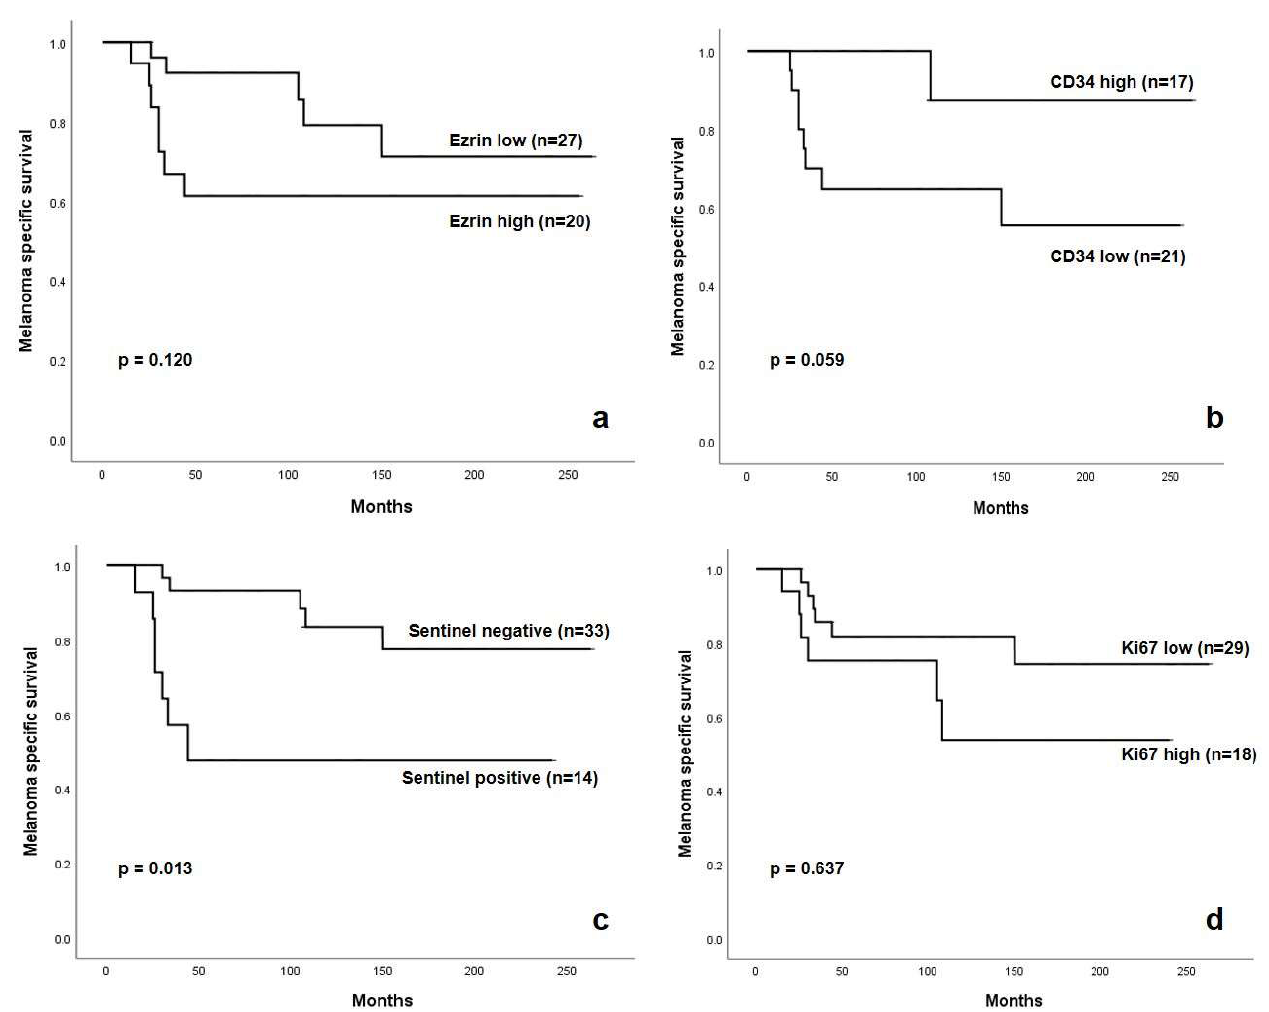
Figure 1. Ezrin expression ( a ), capillary count (CD34; ( b )), sentinel lymph node status ( c ), Ki-67 ( d ) and tumor specific survival. Table 4. Predictors of relative excess melanoma-specific mortality from Cox survival models in the melanoma cancer patient sample. * Denotes a significant p value of <0.05. Unadjusted Hazard Ratio (95%